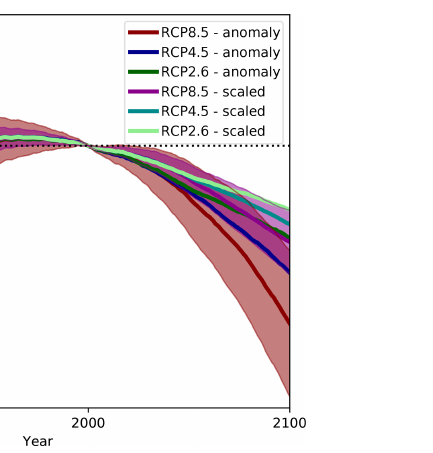
Figure E5. The sea level correction as defined by Eq. (D8) covers the period from 1850 to 2100. Here, the ratio p ( t ) (Eq. D5) is the temporal median for each ensemble member (see Fig. E7 for the corresponding figure assuming that all additional mass loss increases the global simulated sea level). The correction is computed relative to the simulated sea level for each individual simulation for the year 2000 as in Fig. 8. The resulting simulated sea level for the entire period from 1850 to 5000 is depicted in Fig. E6. We use 1431Gtyr − 1 as a reference value for the basal melting rate F B ( t ref ); this value corresponds to the estimate of Depoorter et al. (2013) of 1454 ± 174Gtyr − 1 , whereas ref it falls below the value of 1516 ± 106Gtyr − 1 observed by Liu et al. (2015) and exceeds the rate of 1325 ± 235Gtyr − 1 reported by Rignot et al. (2013). Our reference F B ( t ref ) corresponds to the mean of all of these basal melting estimates: 1431Gtyr − 1 . ref